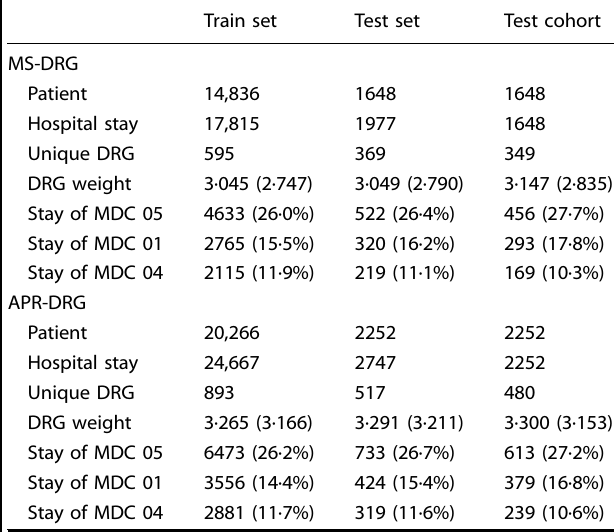
Table 1. Statistics for the two datasets on DRG. Train set Test set Test